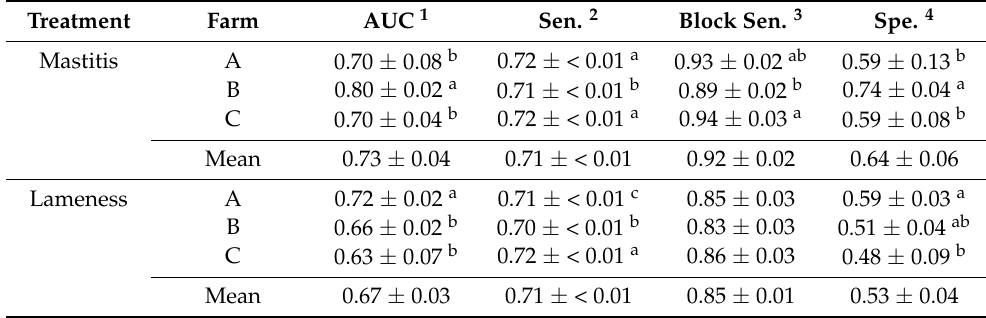
Table 2. Mean area under curve (AUC), sensitivity, block sensitivity, and specificity ( ± 95%-CI) for 5-fold-cross validation data. Training and testing were performed on the same farm.